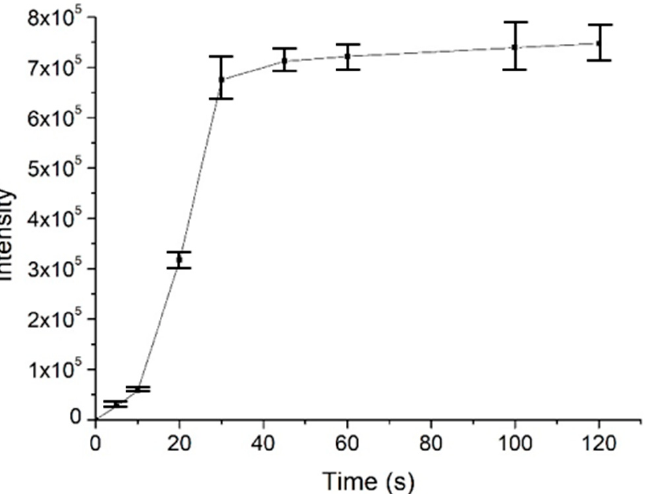
Figure 4. The enrichment performance of the surface-coated needle tip as an SPME probe, using angiotensin II as an example. The experiments were repeated three times ( n = 3).